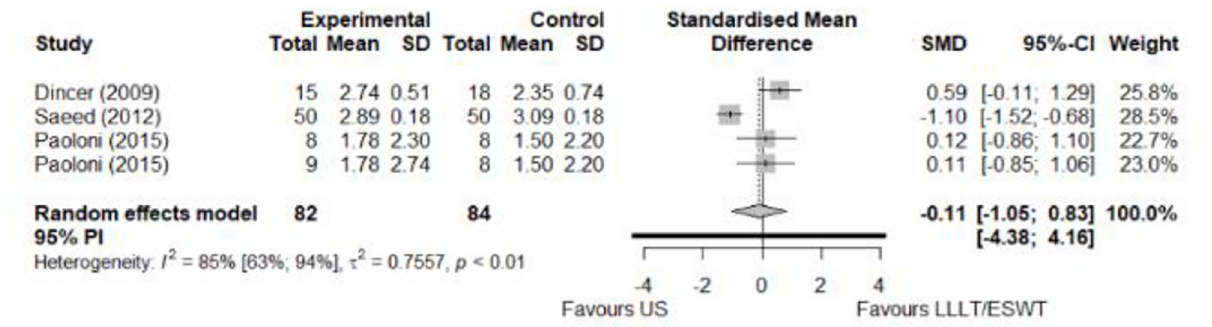
Fig 21. Analysis—Comparison between electrophysical modalities (symptoms severity).